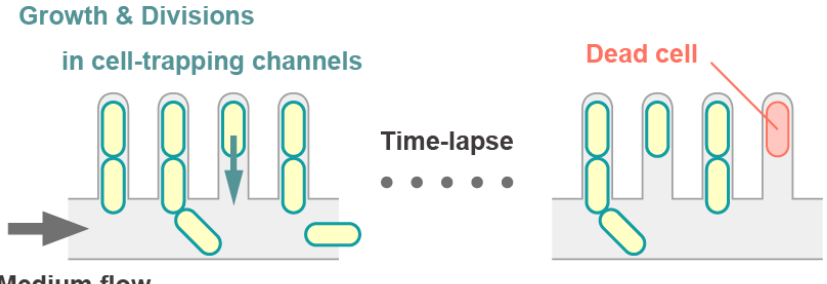
how death and growth rates are related to each other. We found that there is a positive, almost linear correlation physiology of the cells in the faster growing population are better than those in slower growing populations. The